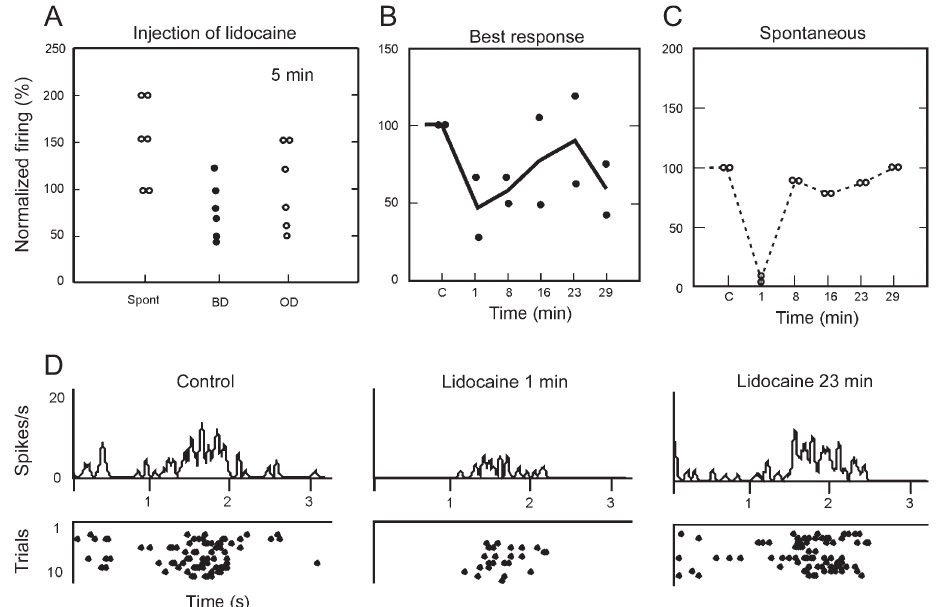
Figure 5. Effects and time course of an injection of 2% lidocaine into area V2 on the response of 6 neurons. A , Effect on the normalized firing rate for the spontaneous activity (Spont), best direction (BD) and other direction (OD) after injection. B , Time course of the effect of lidocaine injection on the best response and C , on the spontaneous activity of 6 neurons. D , Post-stimulus time histograms and spike raster of a neuron at three different times: before (control), and after (1 and 23 min) the injection.